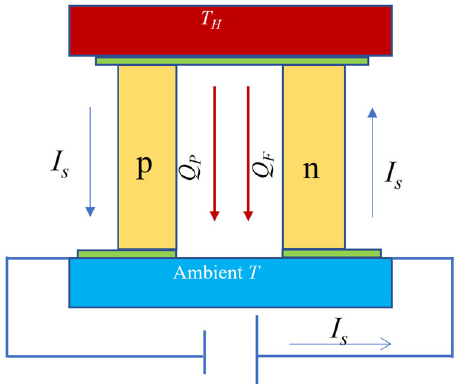
Fig. 1 Schematic diagram of active cooling. The current I s pumps heat from the hot end to the ambient temperature through the p-n leg. Q P and Q F are the heat extracted by the Peltier effect and Fourier effect, respectively.